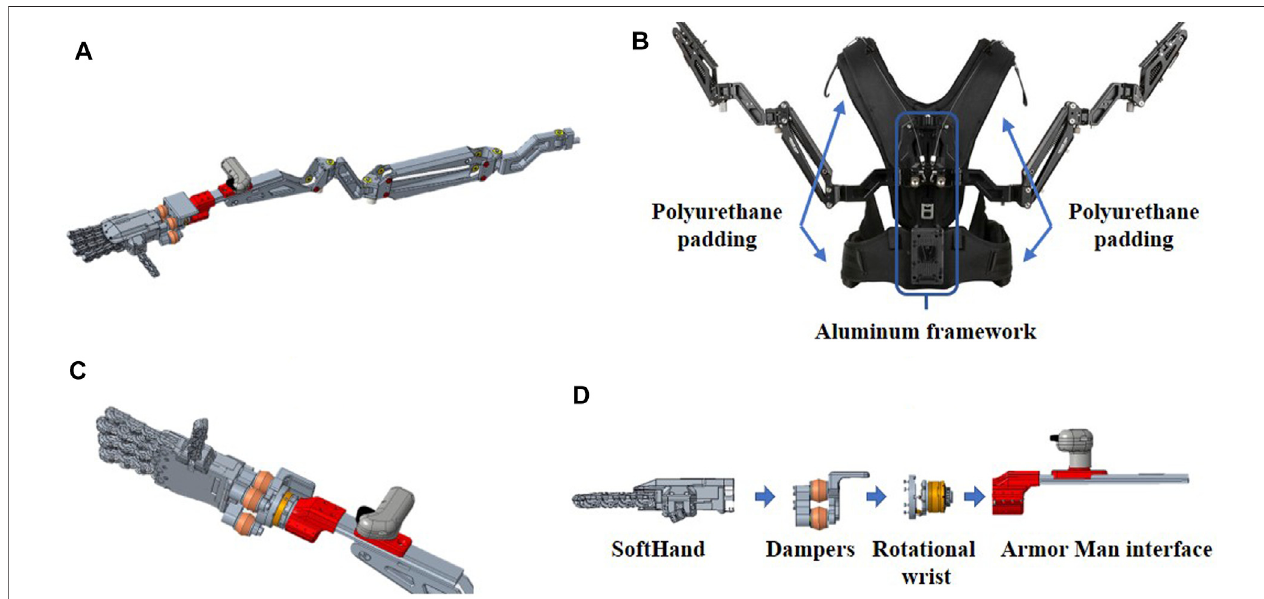
FIGURE3| The3DCADmodeloftheSRLisshown.Picture (A) :thewholecompensatoryarmintegratedwiththerobotichandthroughthecustomdampingwrist. Picture (B) shows the Armor Man, highlighting main parts. Picture (C) : details of the robotic hand with the custom damping wrist and the user handle. Picture (D) : the exploded view of the hand-wrist